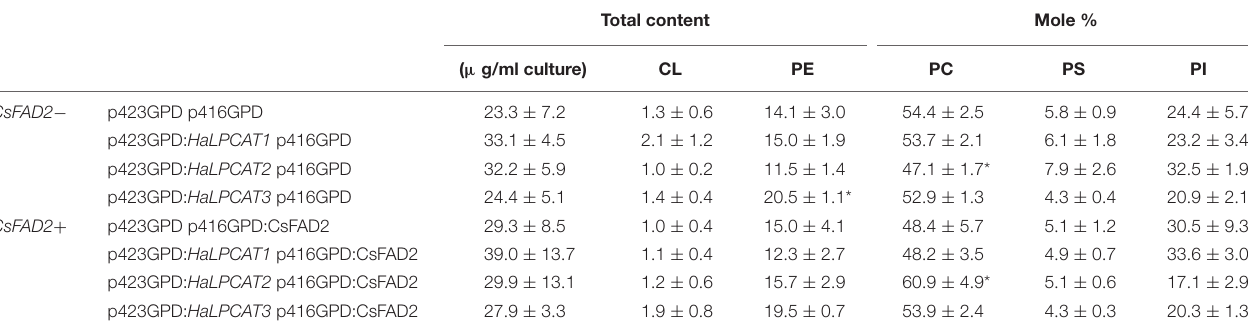
TABLE 1 | Polar lipid content and composition from Saccharomyces cerevisiae strain Y02431 ( slc4 (cid:49) ) expressing LPCATs from sunflower in the absence or presence of expression of a FATTY ACID DESATURASE ( FAD2 ) from Camelina sativa . Total content